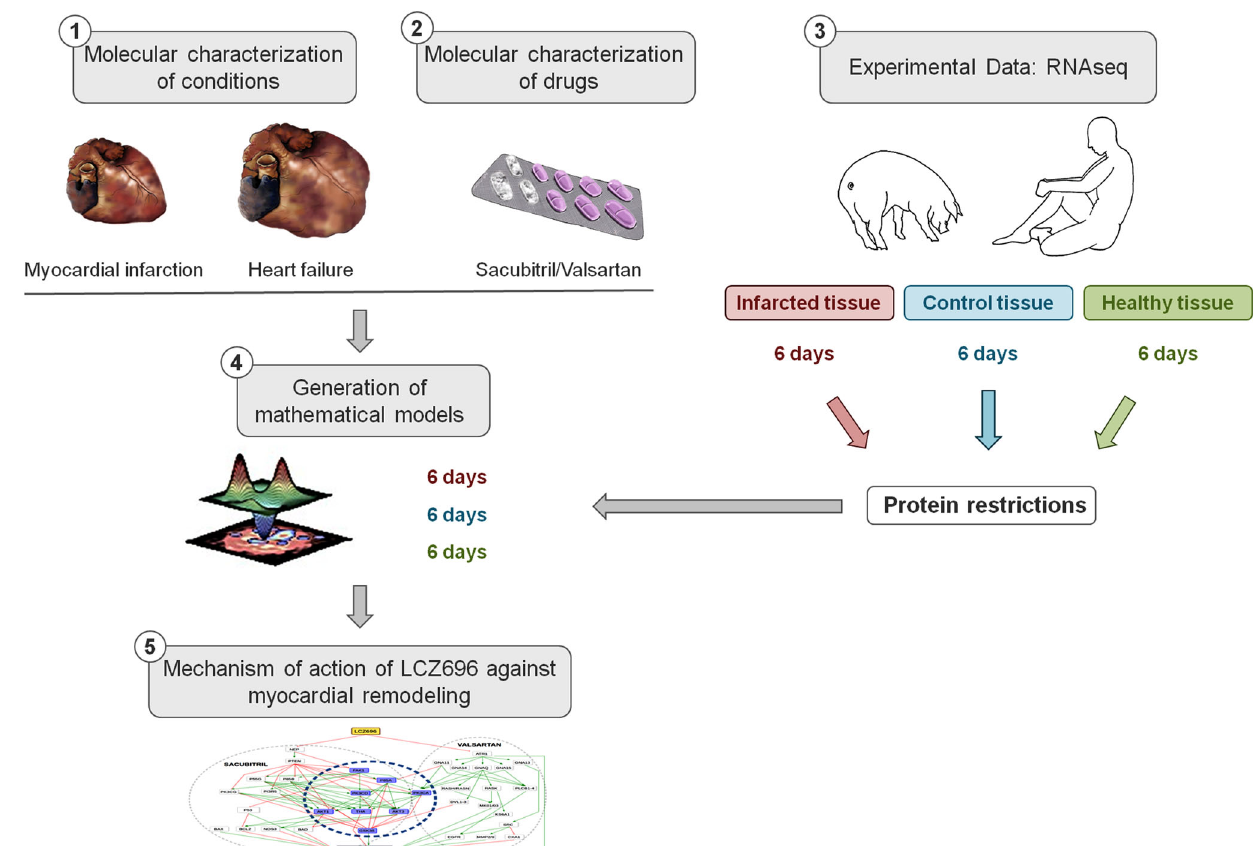
Fig. 3 Depiction of the systems biology approach used to identify the mechanism of action of Sacubitril/Valsartan. At the top left corner , number 1 and number 2 depict the molecular characterization of both pathologies, MI and HF, and the drug under study, Sacubitril/Valsartan. Obtained from data mining, will serve to generate a truth table that every mathematical model must satisfy. At the top right corner , number 3 shows the recollection of experimental data to generate a pathology signature for MI and HF (original pool of proteins). After analyzing all of them, only those previously related to cardiac remodeling and present in both sets of proteins (MI and HF) were used for the study (136 unique proteins), serving as protein restrictions. Number 4 depicts the generation of mathematical models using all the data collected in previous steps 1 – 3. Finally, number 5 displays the graphical representation of the Mechanism of Action (MoA) found by the mathematical models. All these steps, excluding the experimental data generation, explain how TPMS technology works. LCZ696 denotes Sacubitril/